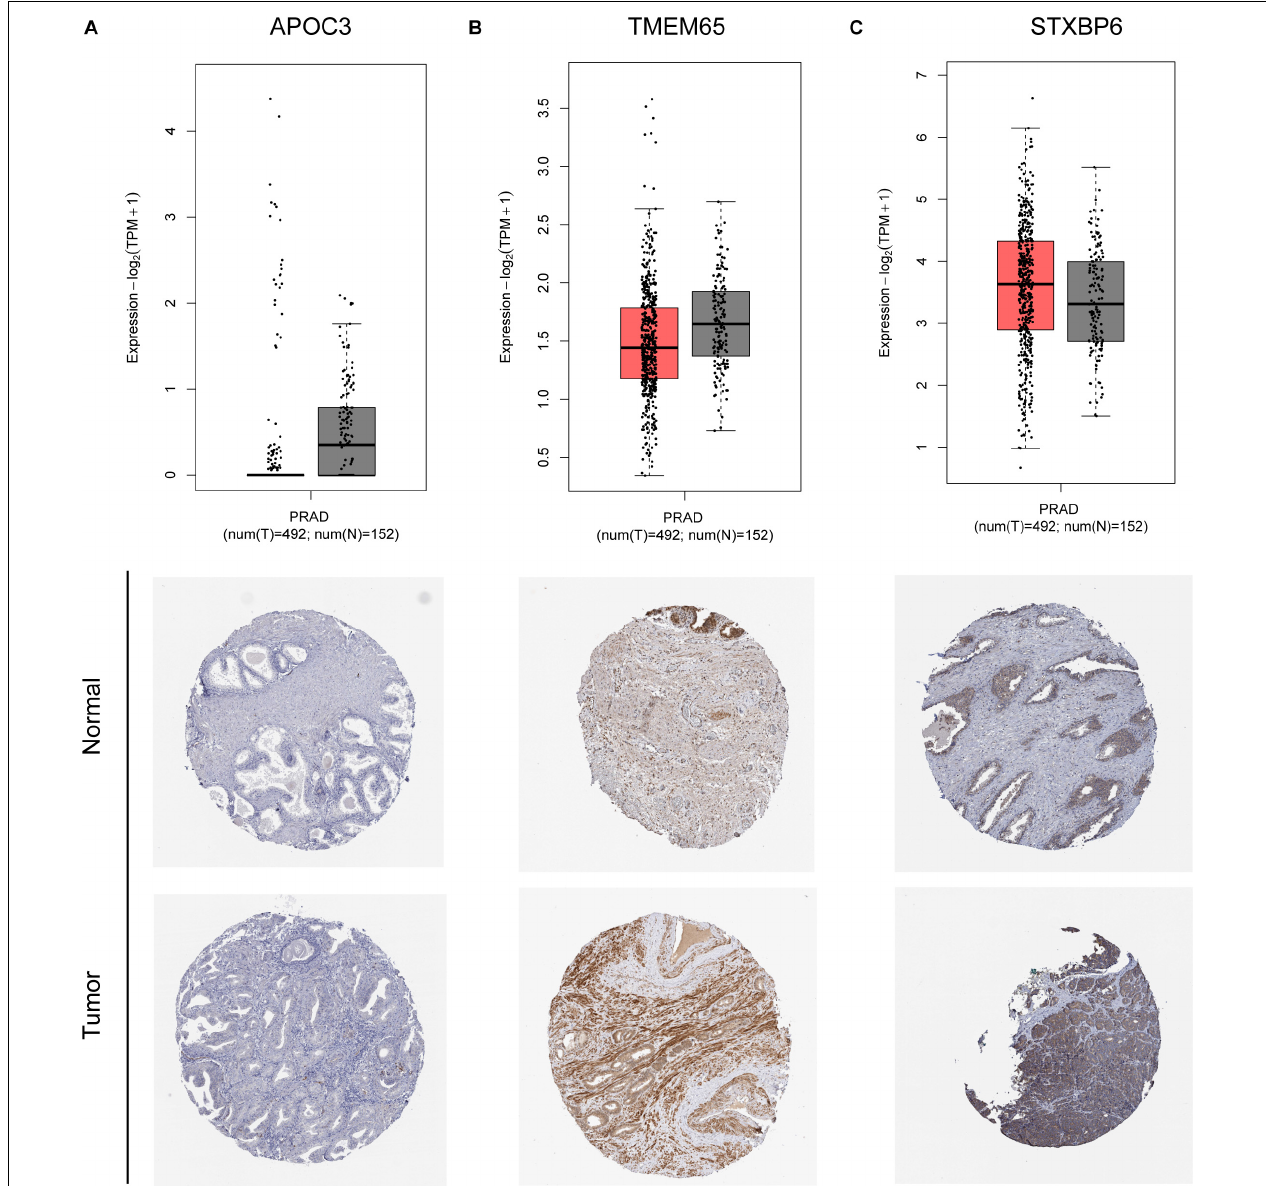
FIGURE 4 | mRNA and protein expression of APOC3 (A) , TMEM65 (B) , and STXBP6 (C) genes of identified circRNAs.